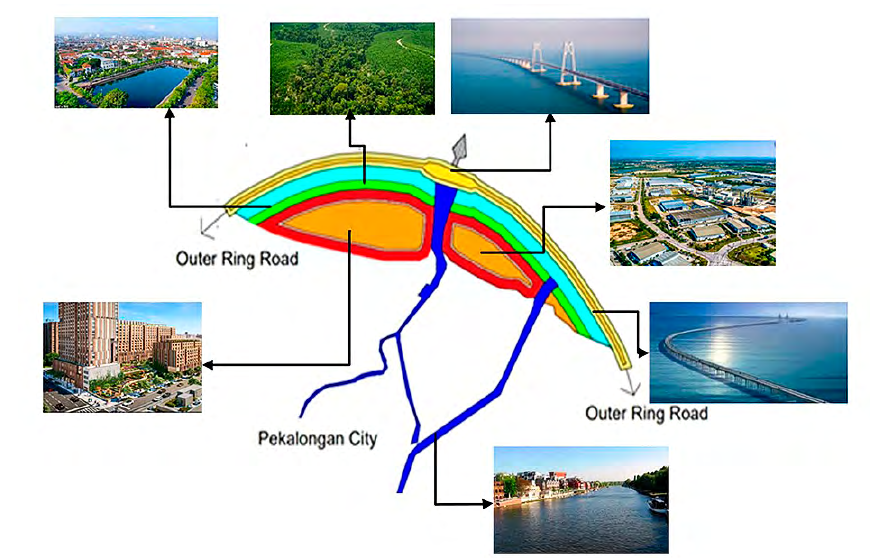
Figure 20. Design Concept for Tidal Floods Pekalongan Flood Management (Alternative